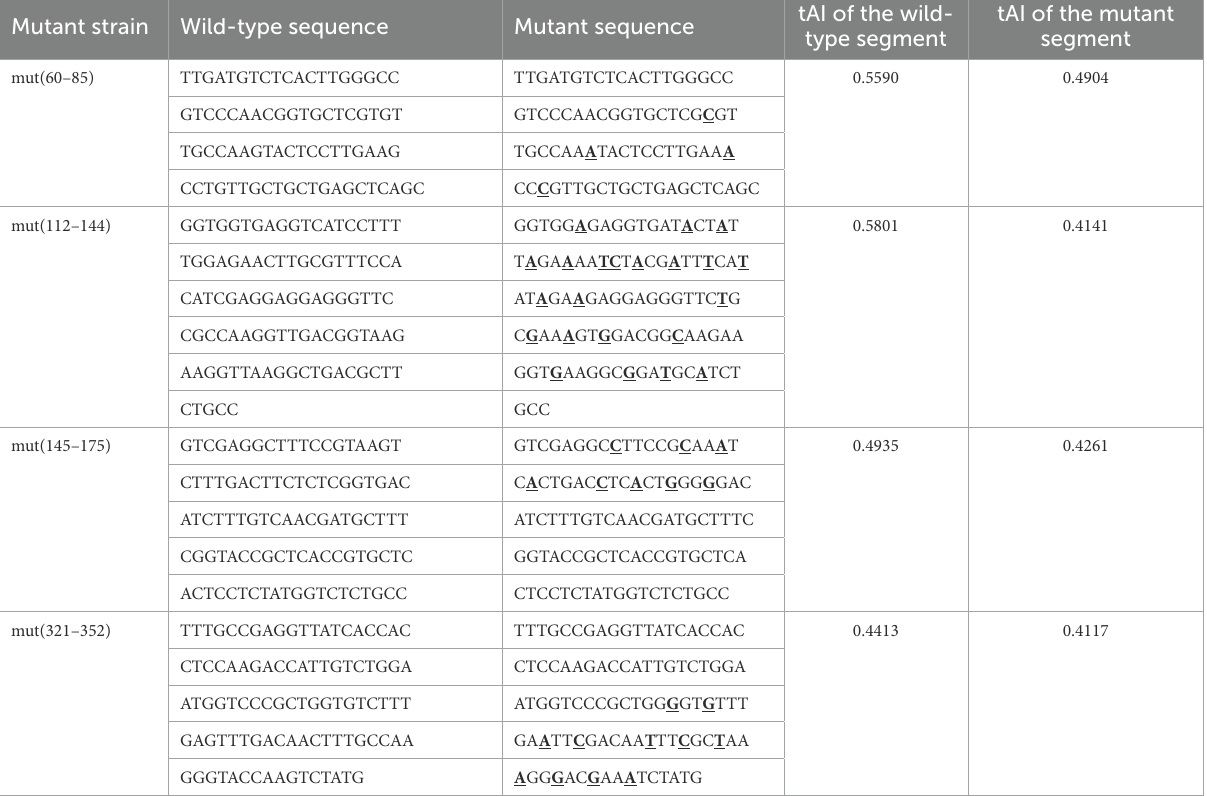
TABLE 2 Wild-type and mutant sequences and tAI calculation of the corresponding mutated regions. Mutant strain Wild-type sequence Mutant sequence